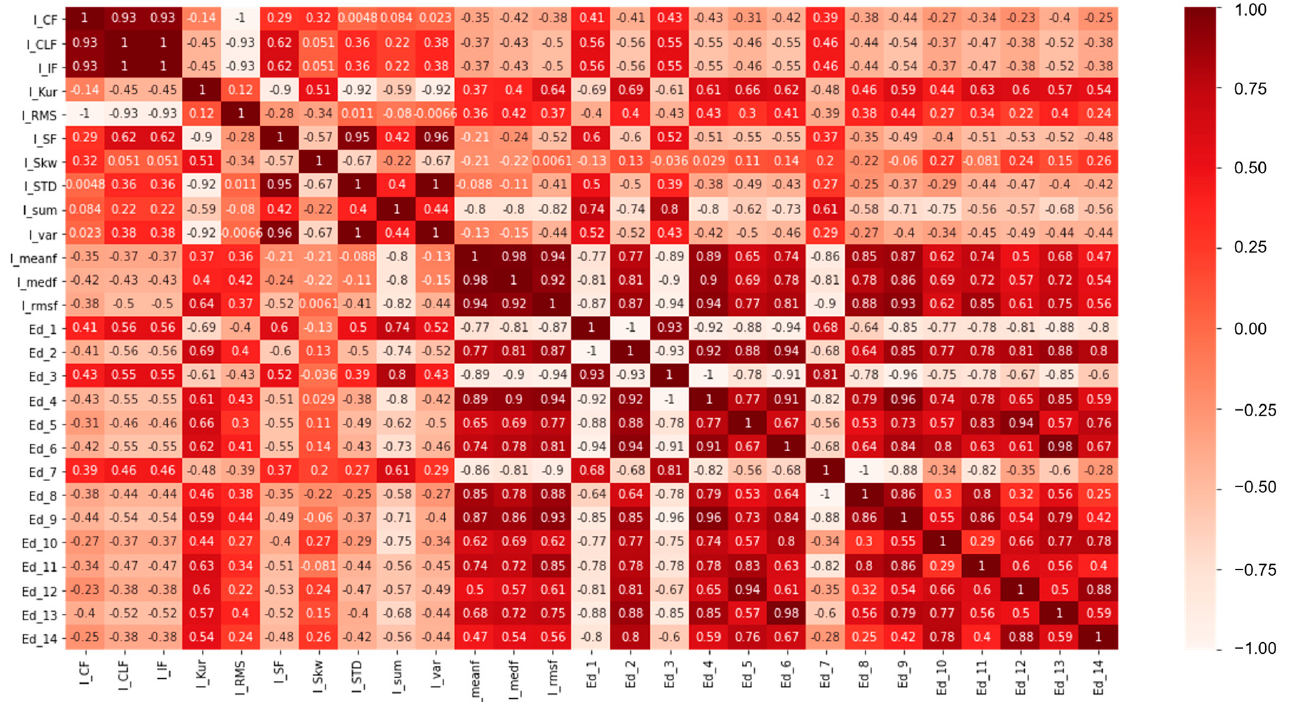
Figure 13. Features selected by removing one of the features whose correlation coefficient exceeds the r value.